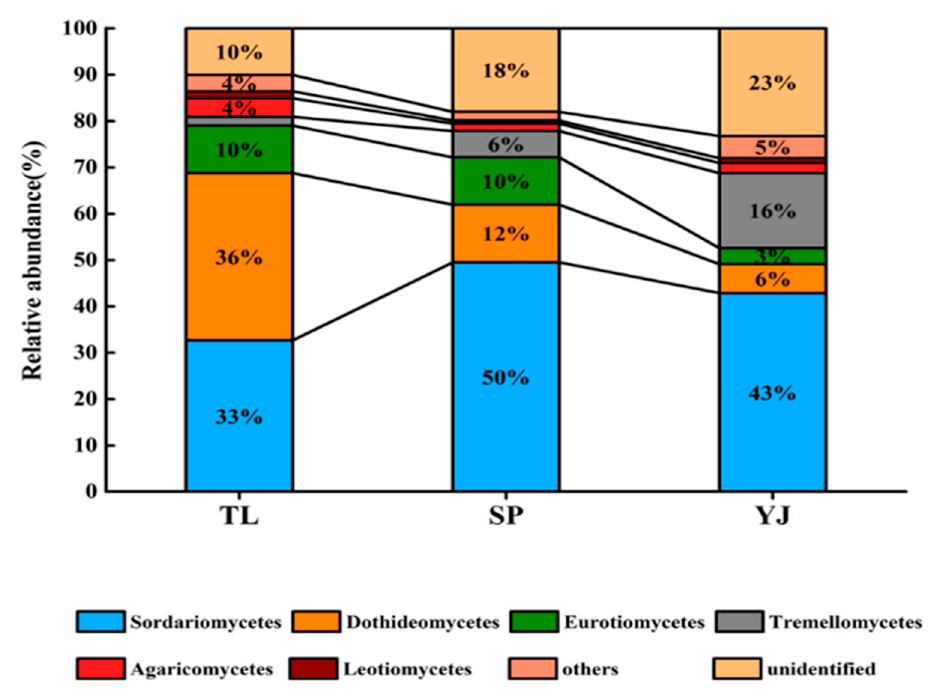
Figure 1. The columnar stacking diagram showing the relative abundance (%) at the class level of fungal communities. TL, SP, and YJ indicate that the soil samples were collected from Tongliao, Siping, and Yanji, respectively.